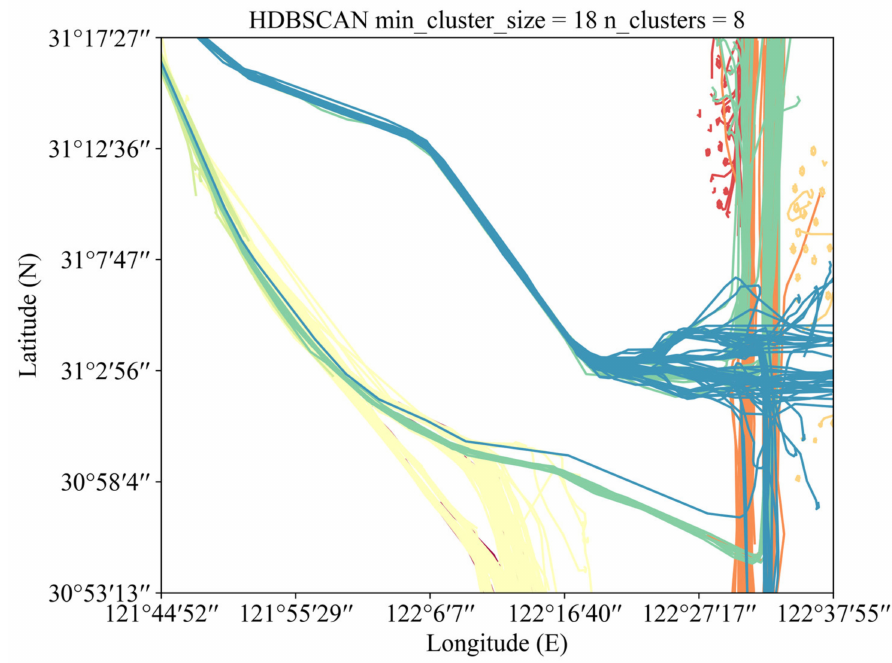
Figure 16. Result of clustering using HDBSCAN with min_cluster_size =